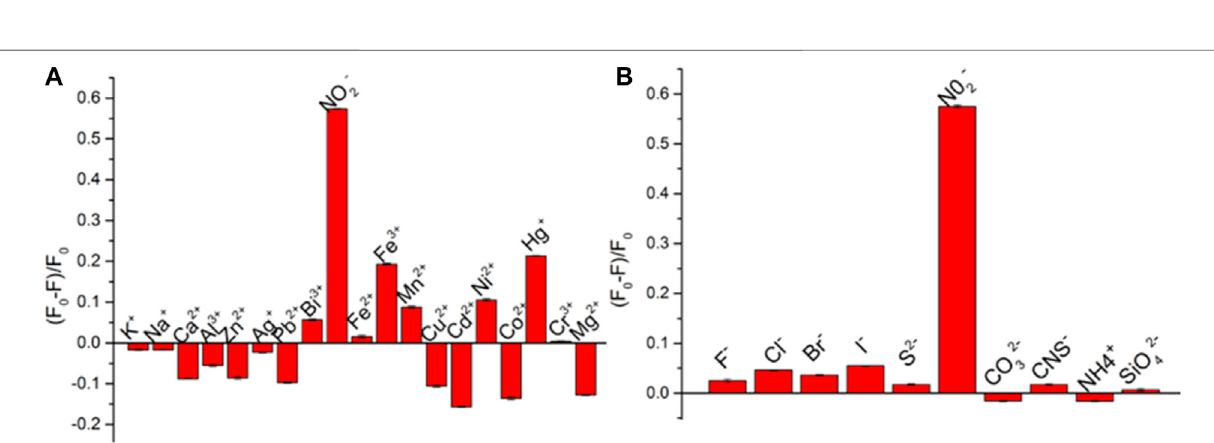
Frontiers in Chemistry |